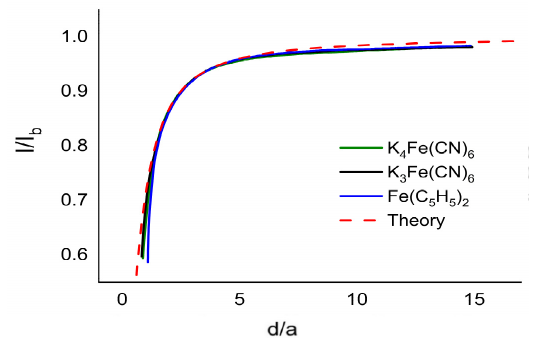
Figure 5. Approach curves recorded with the indicated redox mediator above the unbiased oligo-( S )-BT 2 T 4 -Au. The scheme shown in the inset represents, as an example, the process occurring using Fc as redox mediator.